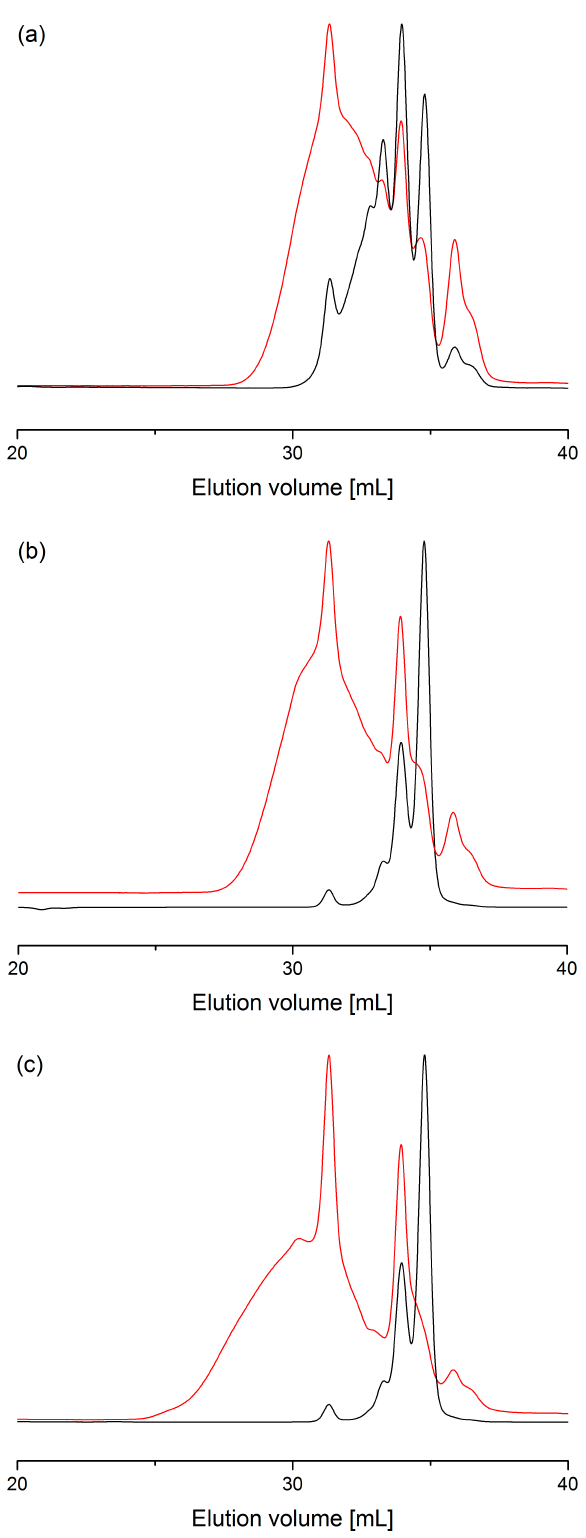
Figure 2. GPC eluogram of glycerol oligomers obtained with K 2 CO 3 (4 wt %) as catalyst: ( a ) 300 W after 20 (black) and 30 min (red); ( b ) 600 W after 5 (black) and 10 min 30 s (red); ( c ) 800 W after 4 (black) and 6 min 20 s (red).